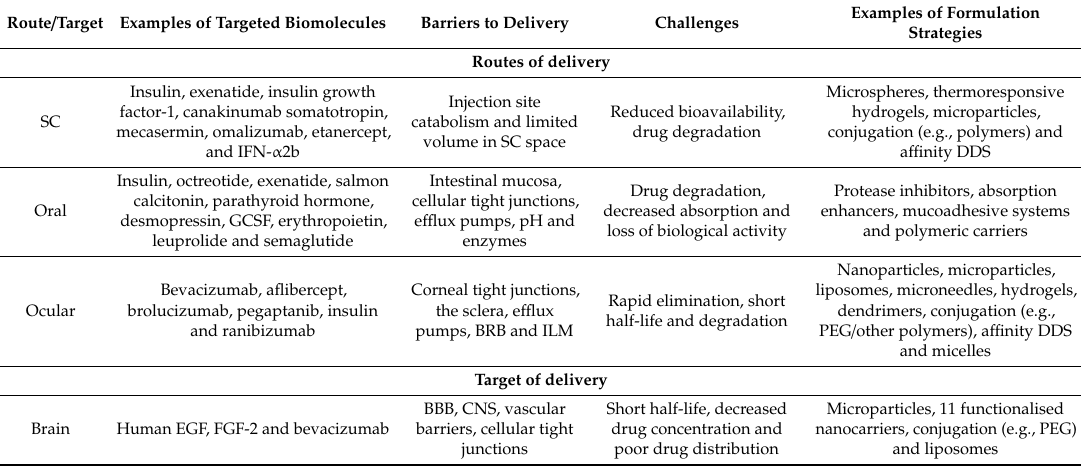
Table 1. Common challenges and barriers with selected routes of administration for the delivery of polypeptides including a few examples of formulation strategies for each route. Route / Target Examples of Targeted